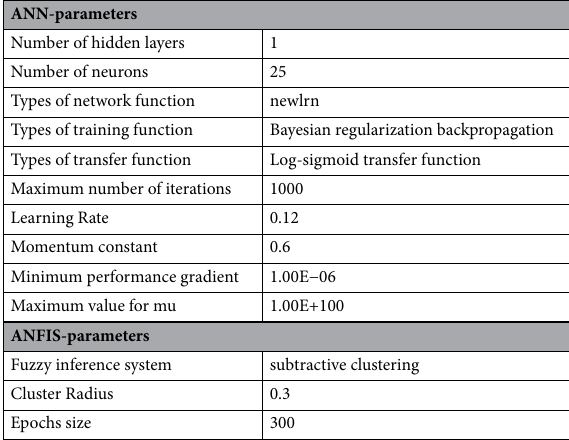
Table 5. Machine learning’s parameters with the best